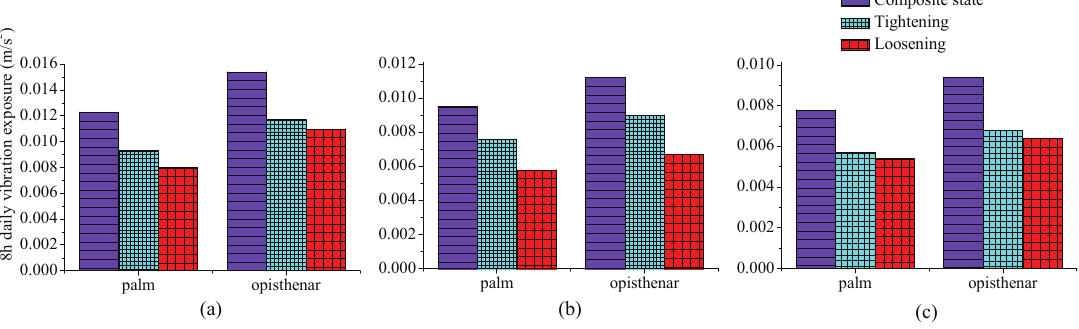
Figure 6. Comparison of the daily vibration exposure of the composite state, tightening and loosening wearing spacesuit glove: ( a ) 400 mm operating rod; ( b ) 300 mm operating rod; and a ( c ) 200 mm operating rod.